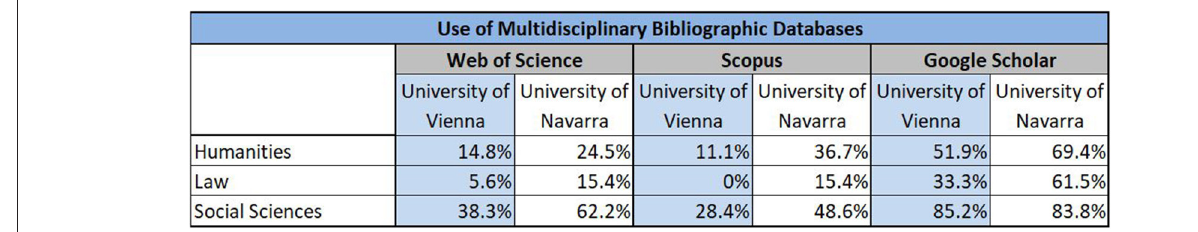
FIGURE 3 | Use of multidisciplinary bibliographic databases.